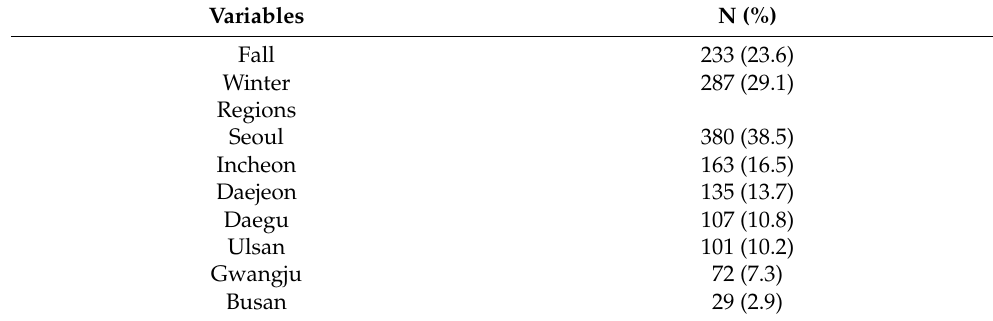
AE-COPD, Acute exacerbation of chronic obstructive pulmonary disease. Table 2 summarizes the average air pollutant concentrations by region. The interquar-